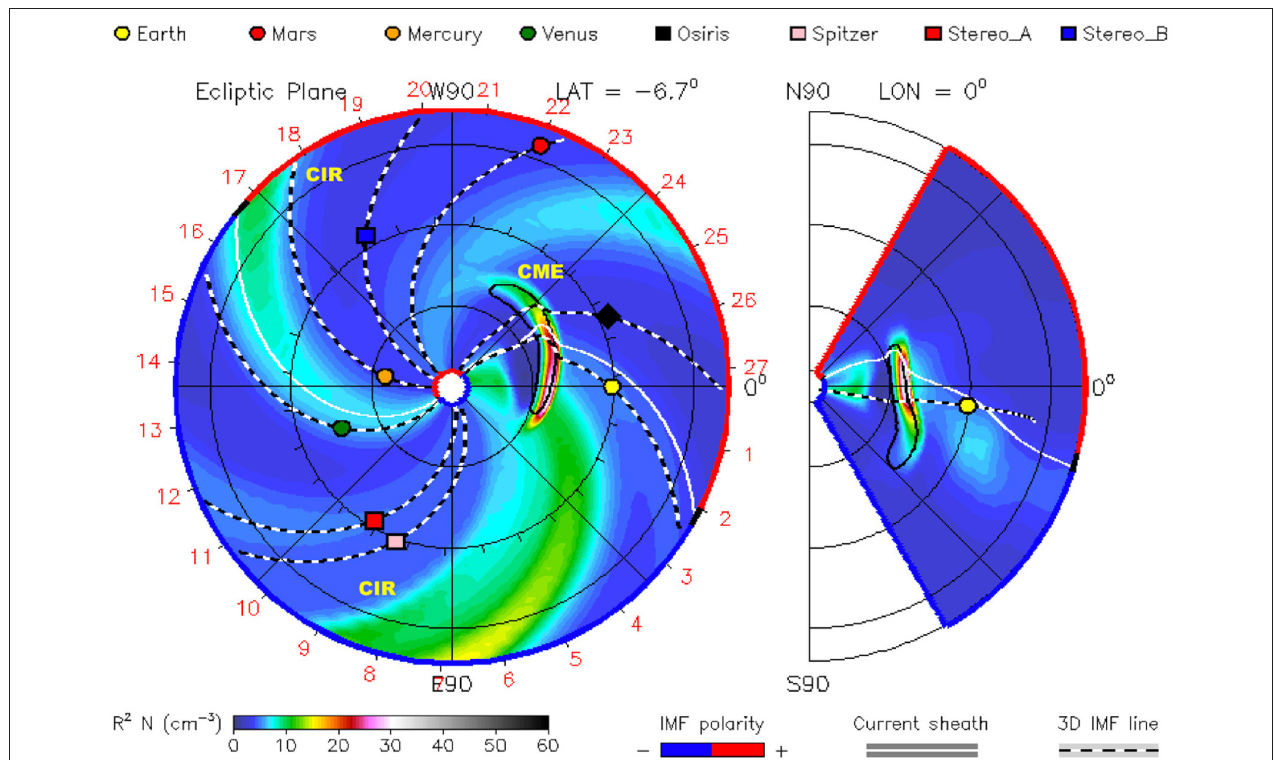
FIGURE 5 | Snapshot of the heliosphere, on 2/14/2018 00:00 UT, from an ENLIL model run at the Community Coordinated Modeling Center. The normalized density is shown. (Left) Polar view showing one CME and two CIRs. Earth is magnetically connected to the incoming CME. The interaction of the CME and a CIR is evident in this view. (Right) Meridional cut at the location of Earth. It approximates the view from a heliospheric imager in Earth